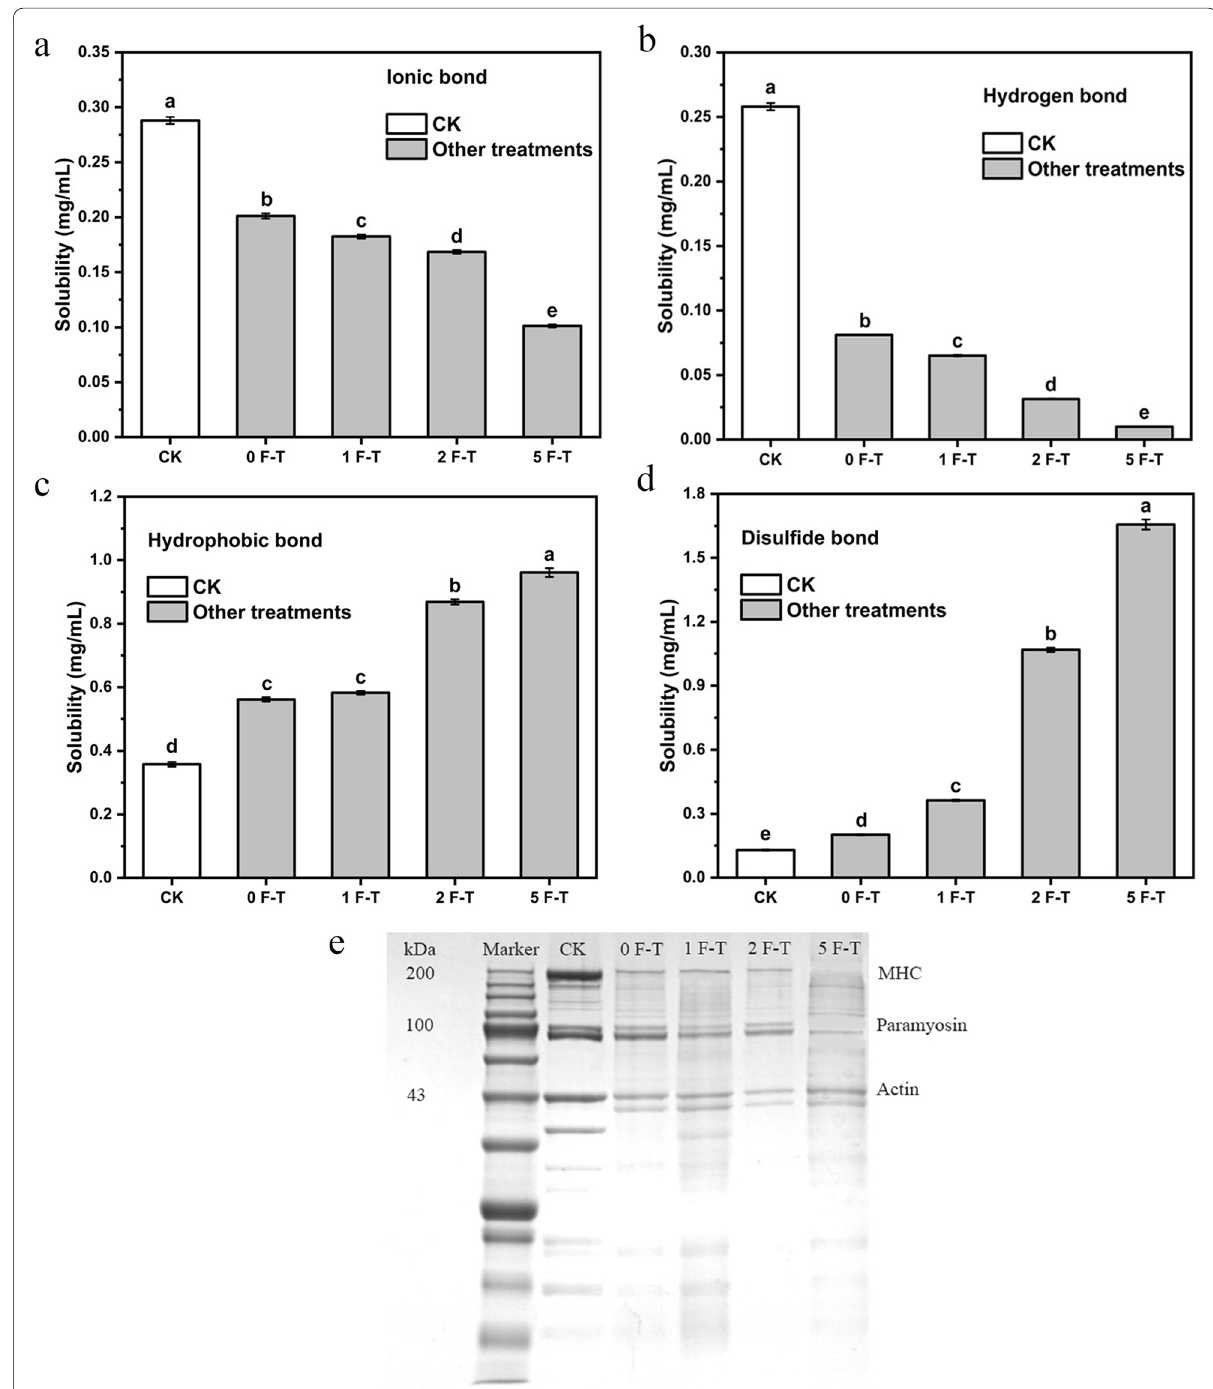
Fig. 3 Effect of repeated freeze-thaw cycles on the chemical forces in cooked crayfish ( a – d ) and SDS-PAGE patterns of MPs of cooked crayfish with repeated freeze-thaw cycles ( e ) (CK: fresh crayfish; 0 F-T: cooked crayfish with 0 freeze-thaw cycles; 1 F-T: cooked crayfish with 1 freeze-thaw cycle; 2 F-T: cooked crayfish with 2 freeze-thaw cycles; 5 F-T: cooked crayfish with 5 freeze-thaw cycles). Different letters in the same column of the same indicator showed significant difference ( p < 0.05